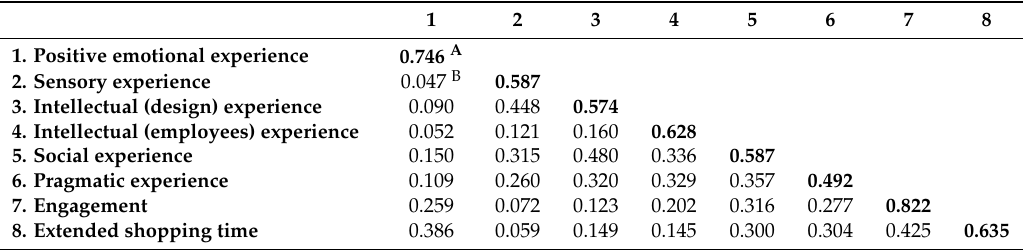
Table 4. Discriminant validity analysis of the proposed